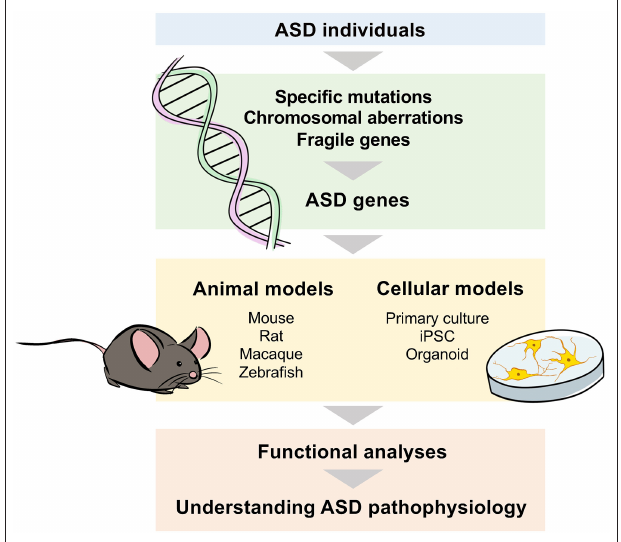
FIGURE 2 | Genomic approaches to understand the mechanisms underlying ASD pathophysiology. To identify the genes involved in the pathophysiology of ASD, genome or gene expression analyses with samples such as blood and postmortem brains from individuals with ASD are performed to identify disease-specific mutations, chromosomal aberrations, and fragile genes. Cellular and animal models are used to analyze the genes identified in ASD individuals, and functional analyses are conducted based on the strength of each